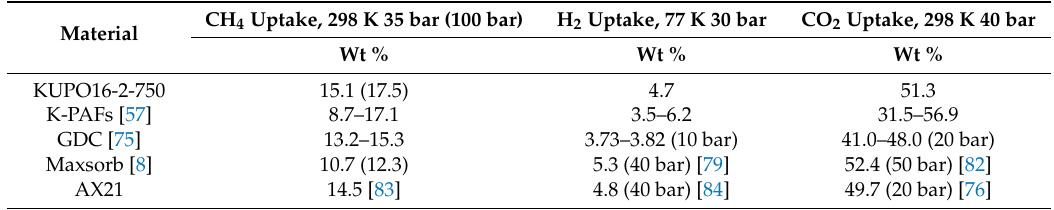
Table 4. Methane, hydrogen, and carbon dioxide uptake for different materials evaluated at different pressures and temperatures.